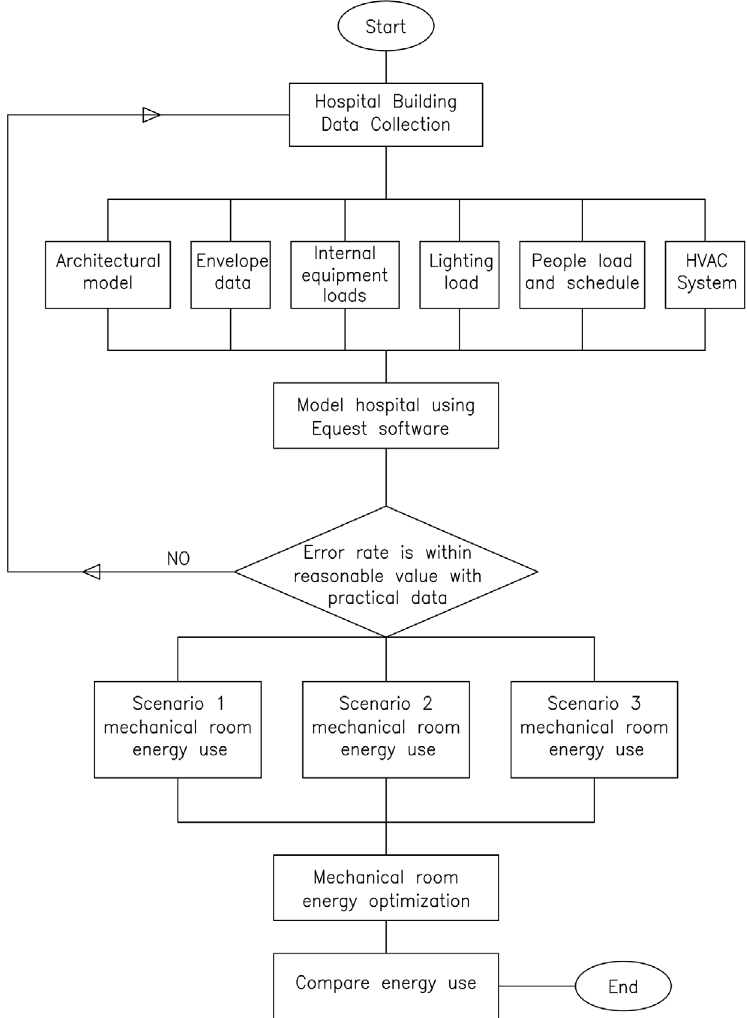
Fig. 2. Algorithm of